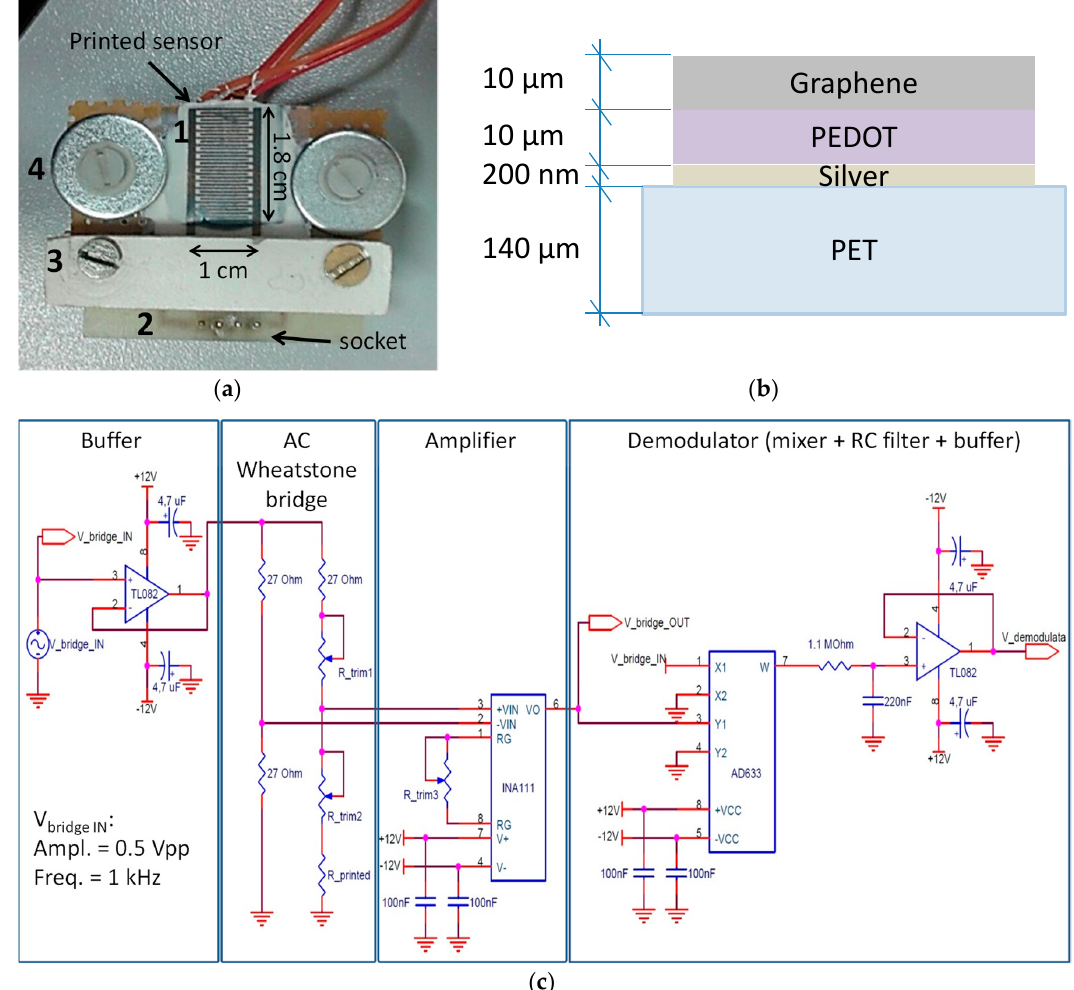
Figure 1. ( a ) The real view of the sensor. The sensor dimensions are: 1.8 cm by 1 cm, with a thickness of about 140 µm. The IDT fingers (1) have a width of 200 µm, a length of 6 mm, a thickness of 200 nm and a track spacing of 350 µm. A customized socket was used to convey signals to the conditioning electronics (2) and blocked by screws (3). Washers and screws (4) have been also used to fix the sensor to the experimental setup; ( b ) the sensor structure (not in scale) and ( c ) the electronics adopted for conditioning the CO 2 printed sensor.